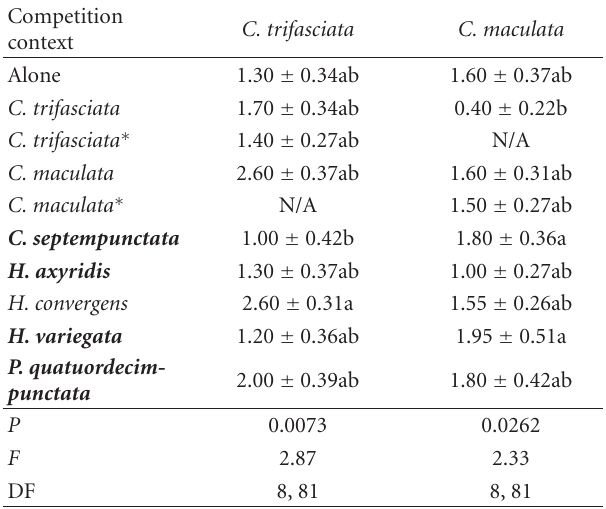
Table 2: Number of aphids (mean ± SE) consumed by C. trifasciata and C. maculata in di ff erent competition contexts (see text for de- tails). Means in each column followed by the same letter are not significantly di ff erent from each other (Tukey’s HSD tests, P < 0 . 05). Nonnative species are printed in bold